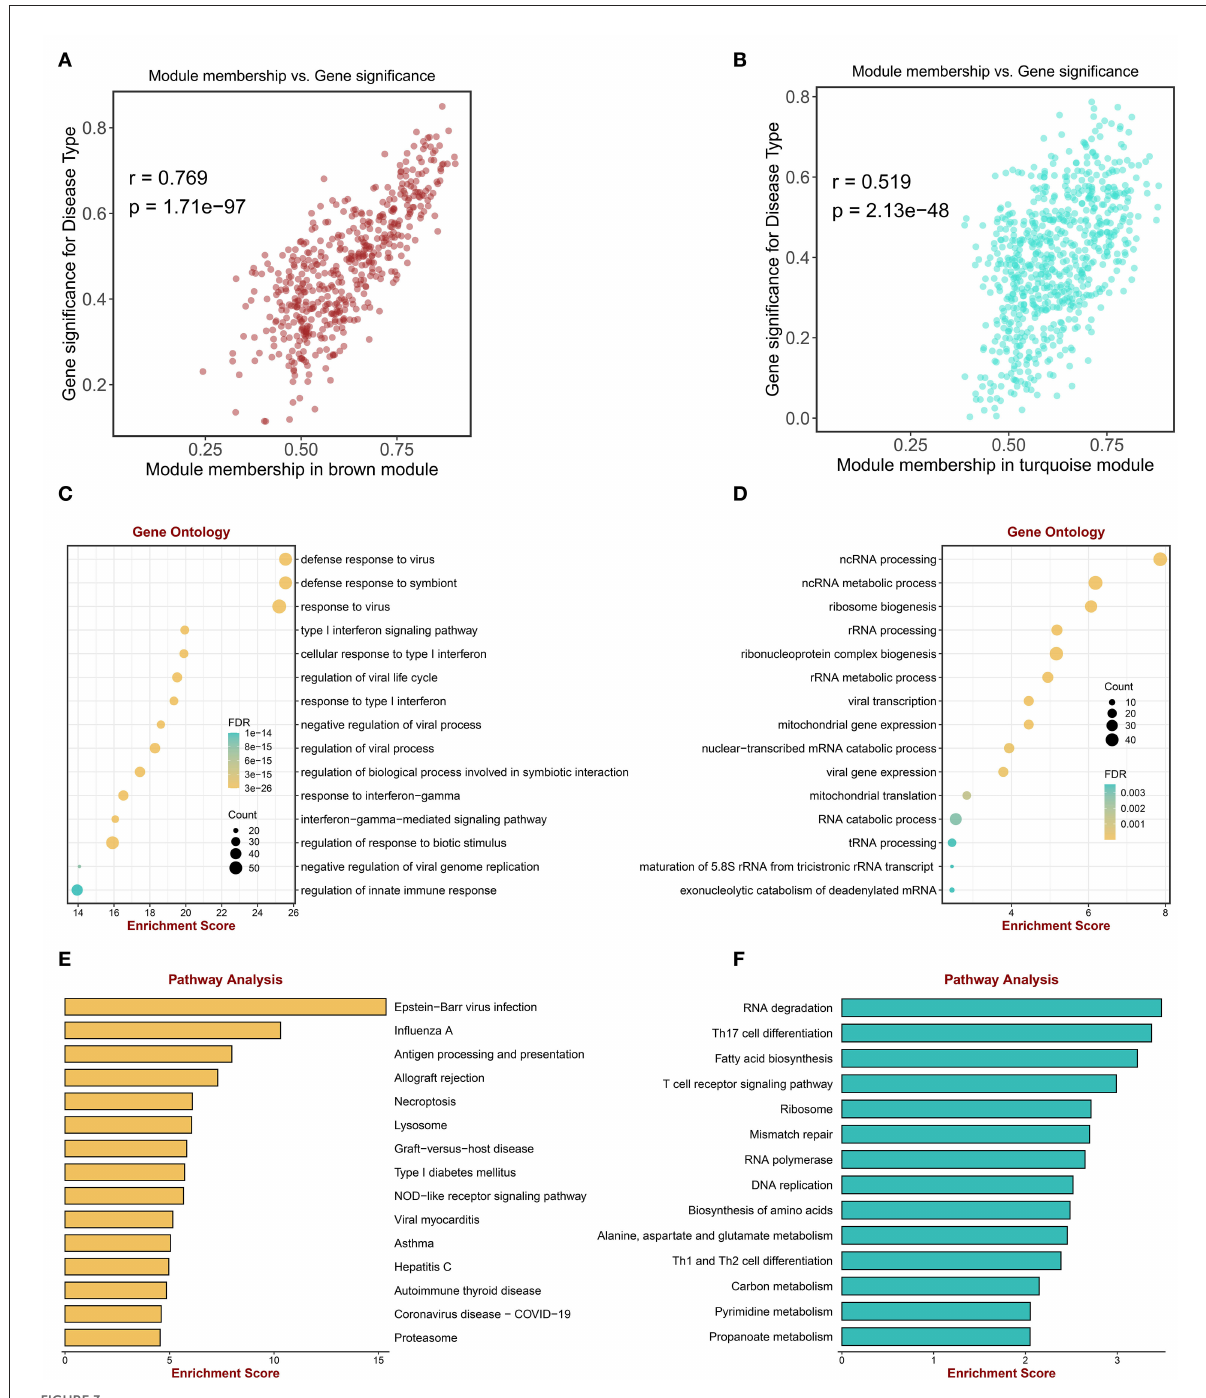
FIGURE3 Enrichment analysis of genes in key MEs. (A) The scatter plot correlation between the brown module membership and gene significance. (B) The scatter plot of correlation between the turquoise module membership and the gene significance. (C) Go enrichment analysis of genes in the brown module. (D) GO enrichment analysis of genes in the turquoise module. (E) KEGG pathway analysis of genes in the brown module. (F) KEGG pathway analysis of genes in the turquoise